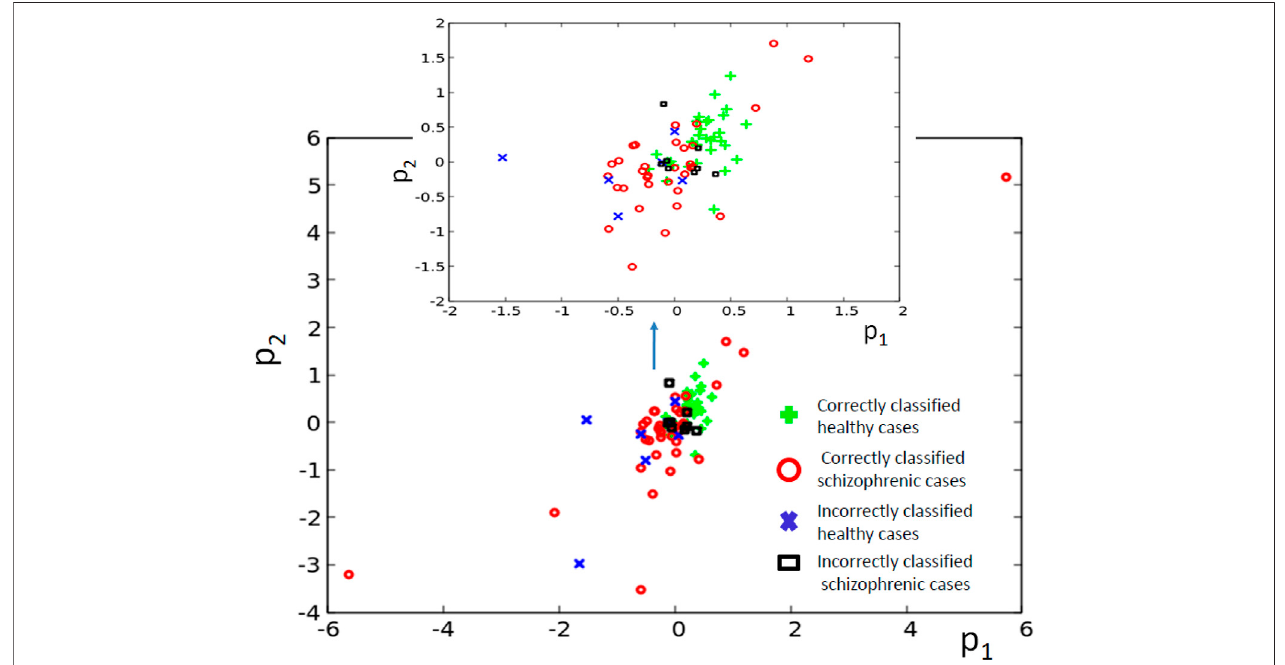
FIGURE 10 | The distribution of correctly and incorrectly classi fi ed cases for 5-oscillator network (cf. Figure 2C ) in the phase space ( p 1 , p 2 ).